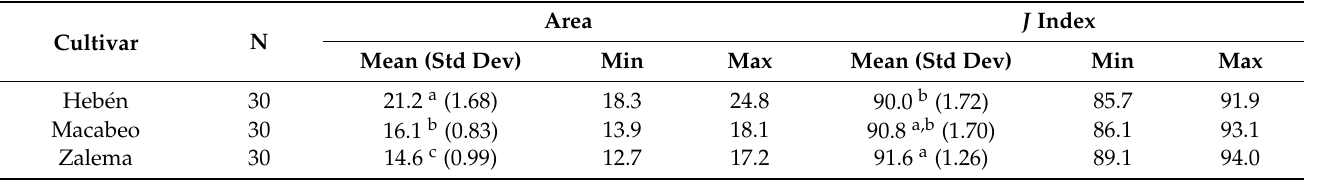
Table 6. Values of area and J index in the cultivars of the Heb é n group. Superscript letters indicate the results of Scheff é test: the mean values marked with the same letter in the superindex of each column do not differ significantly at p < 0.05. N is the number of seeds analyzed.